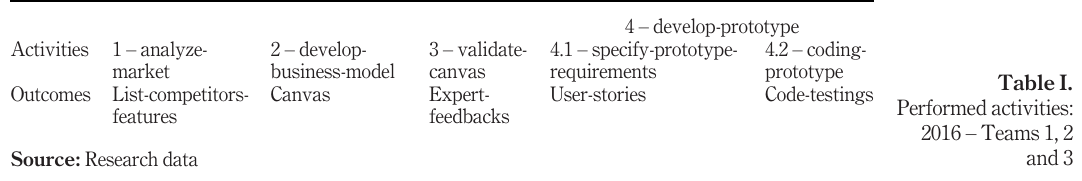
Table I. Performed